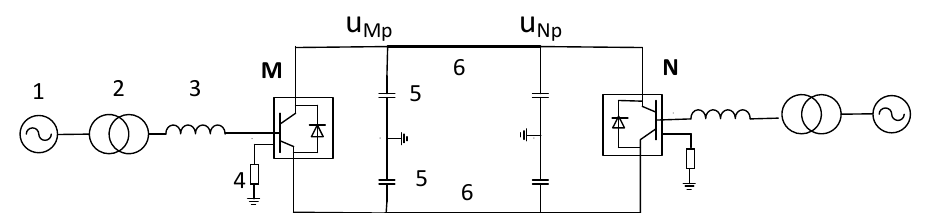
Figure 6. Schematic diagram of VSC-HVDC DC transmission system.